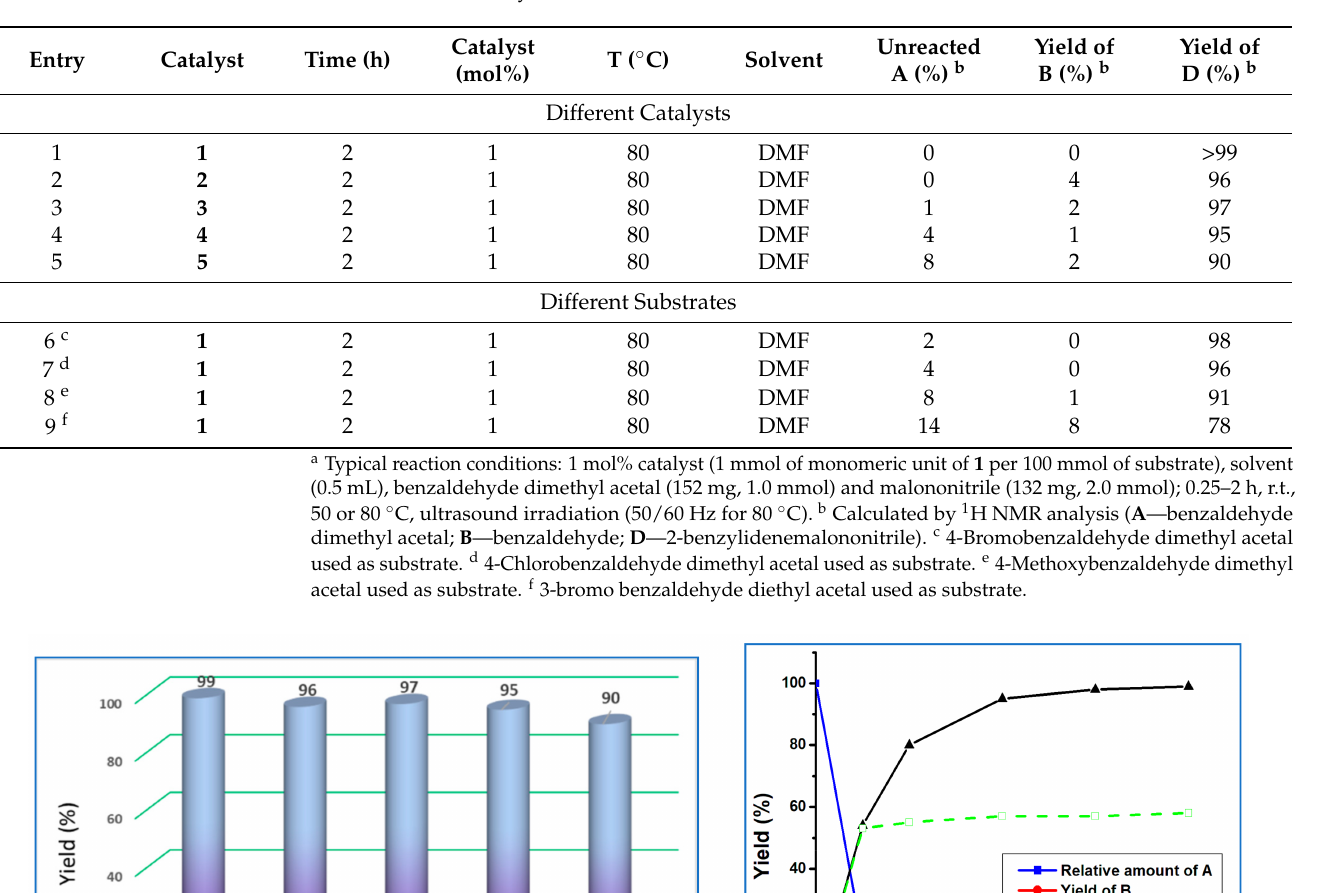
Table 1. Deacetalization–Knoevenagel tandem reactions between benzaldehyde and malononitrile with CPs 1 – 5 as catalysts and under ultrasound irradiation a .